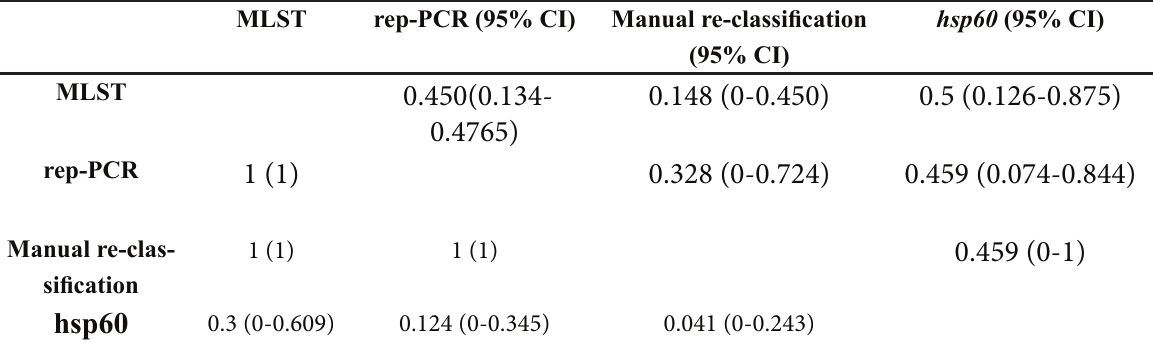
Table 4. Adjusted Wallace Coefficient and 95% Confidence Intervals (CI) within hsp60 sequenc- ing, rep-PCR, and